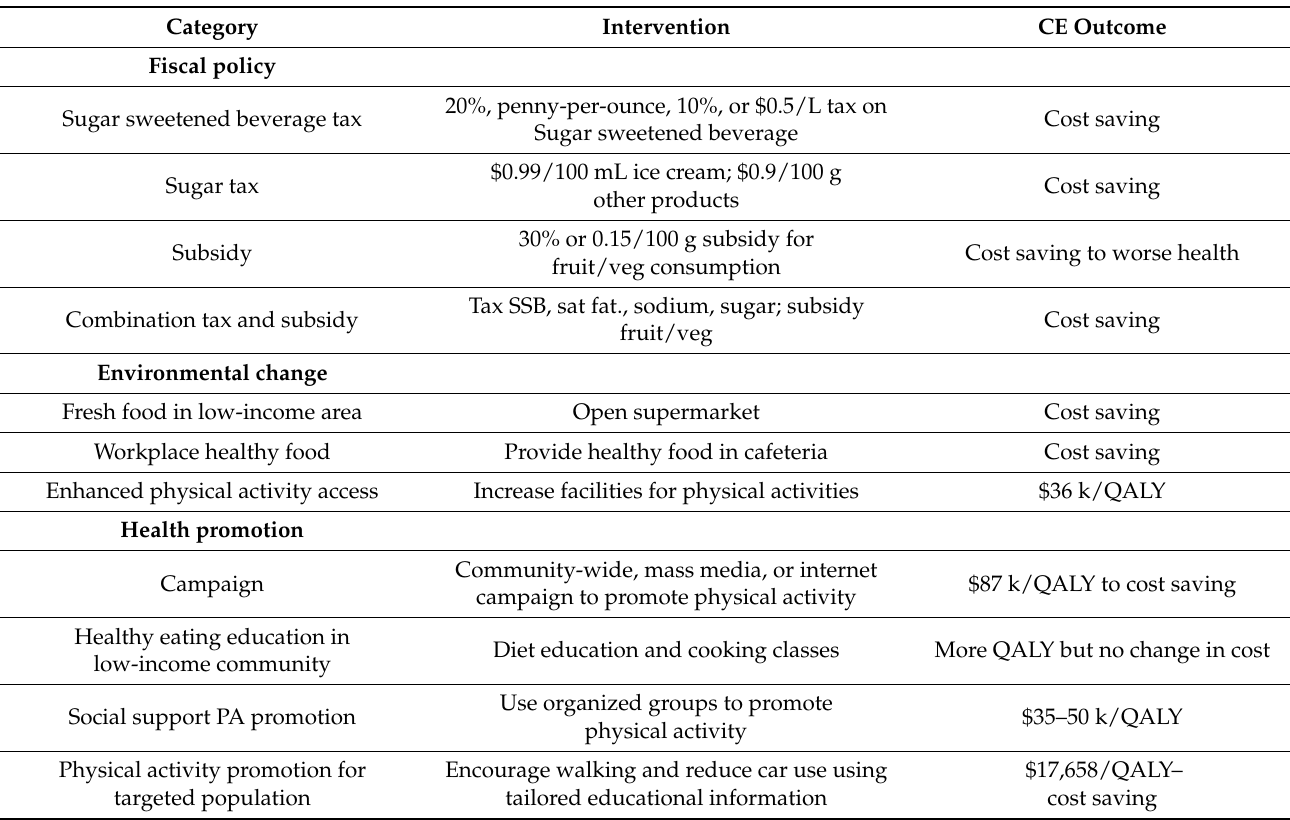
Table 3. Summary of the cost-effectiveness of whole population policies to prevent T2D (modified from the reference